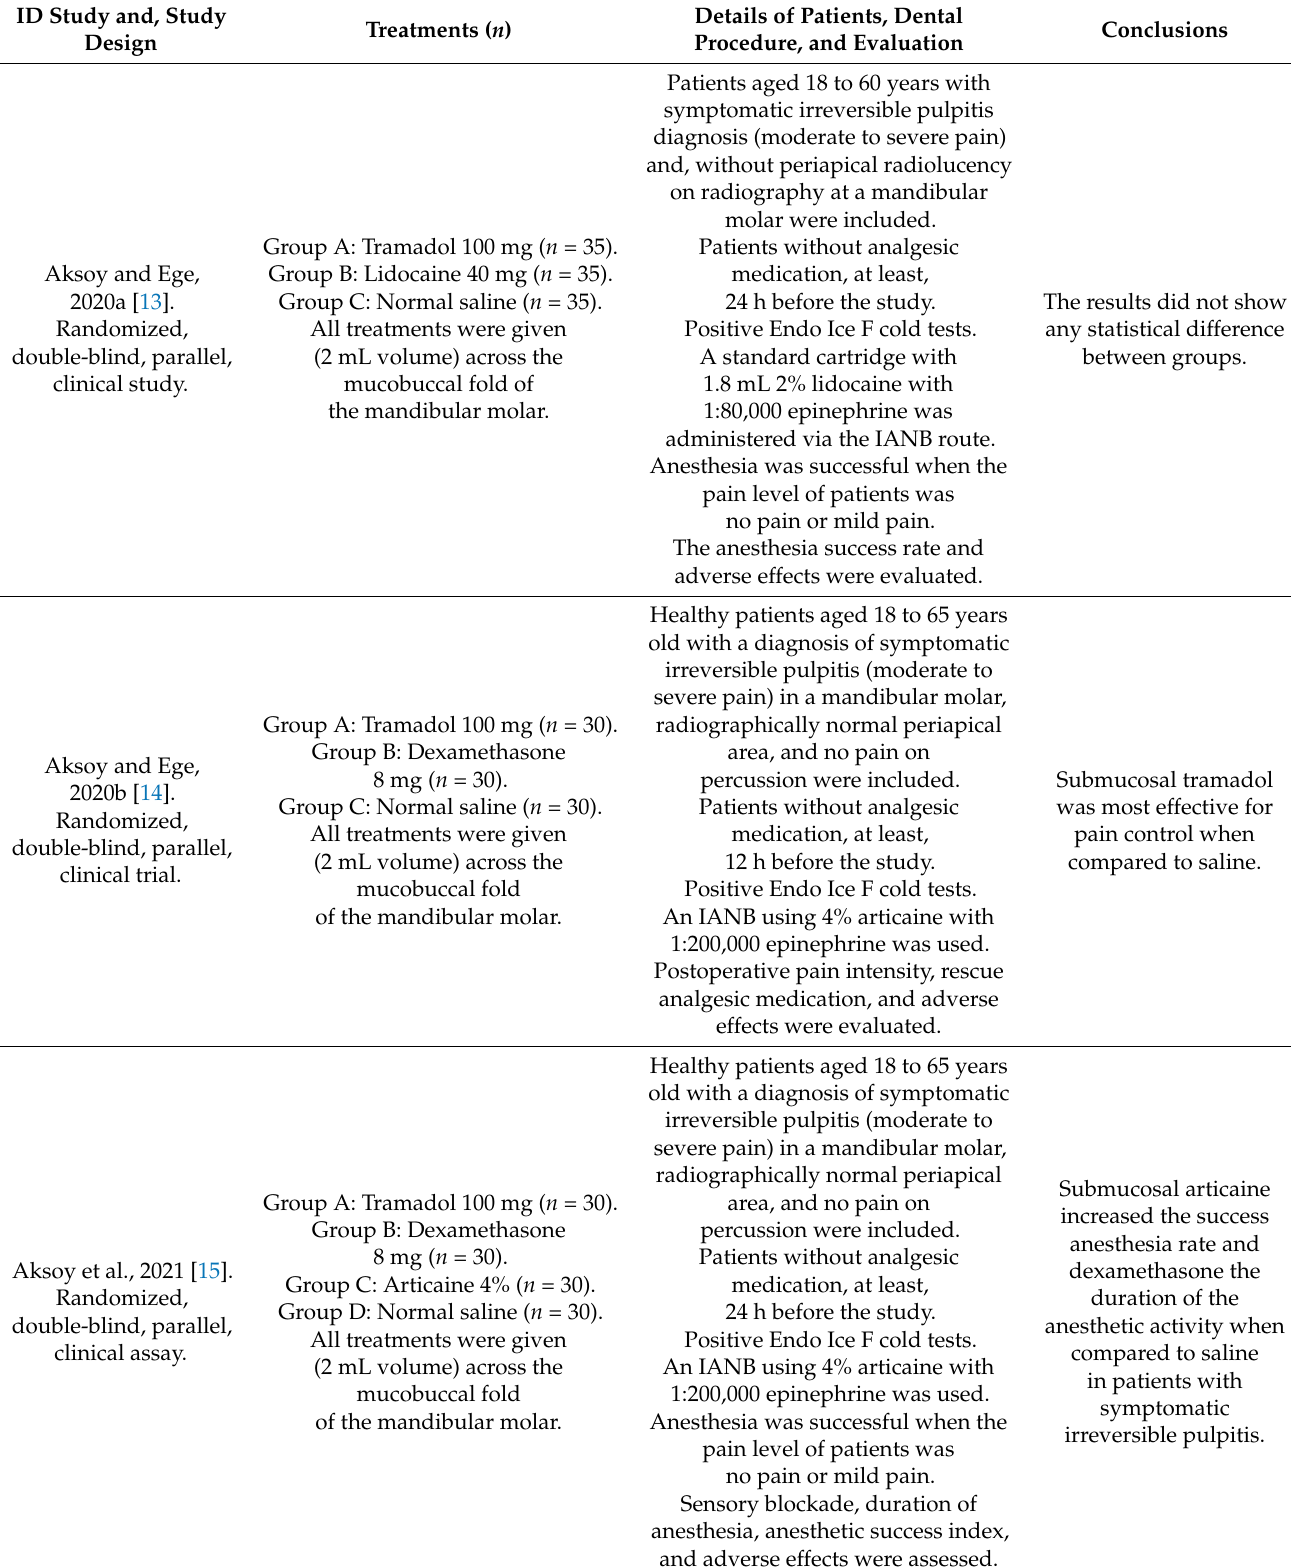
Table 1. Identification of study, study design, treatments ( n ), patients, dental procedure, clinical evaluation, and conclusion of the included